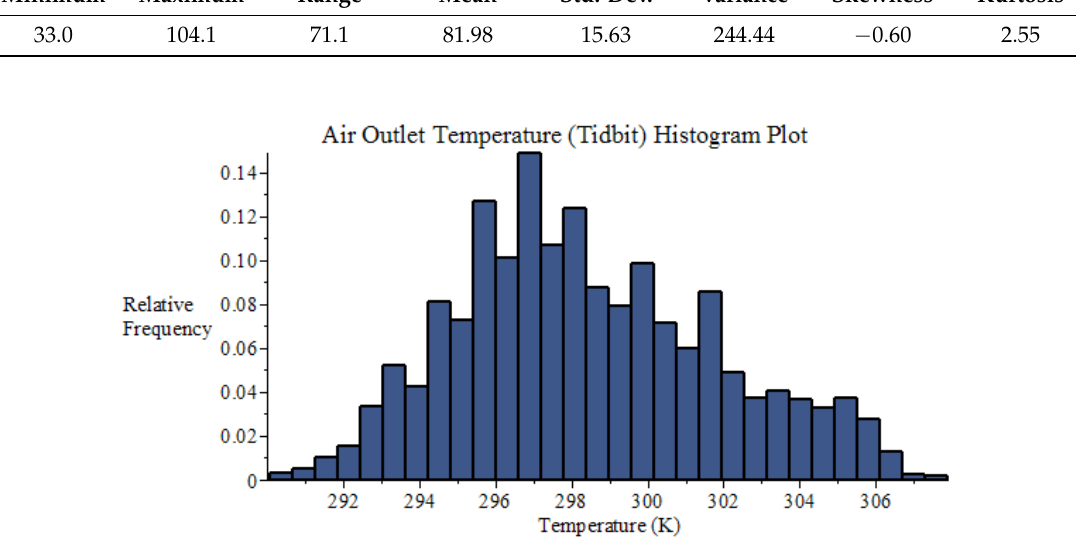
Figure A3. Histogram plot of the air outlet temperature measured using “Tidbit” sensors, within the 7688 data sets collected by SRNL from F-Area cooling towers (unsaturated conditions). Table A2. Statistics of the air outlet temperature distribution [K], measured using “Tidbit” sensors.